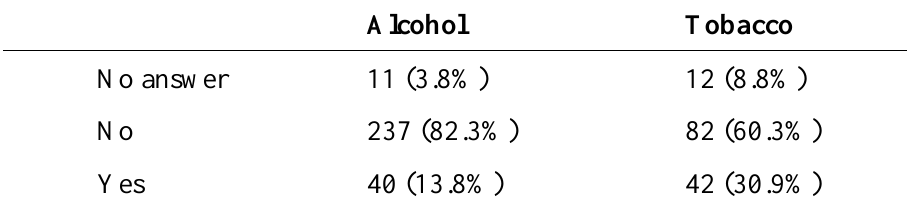
Table 3: Proportion of participants who tried to quit the